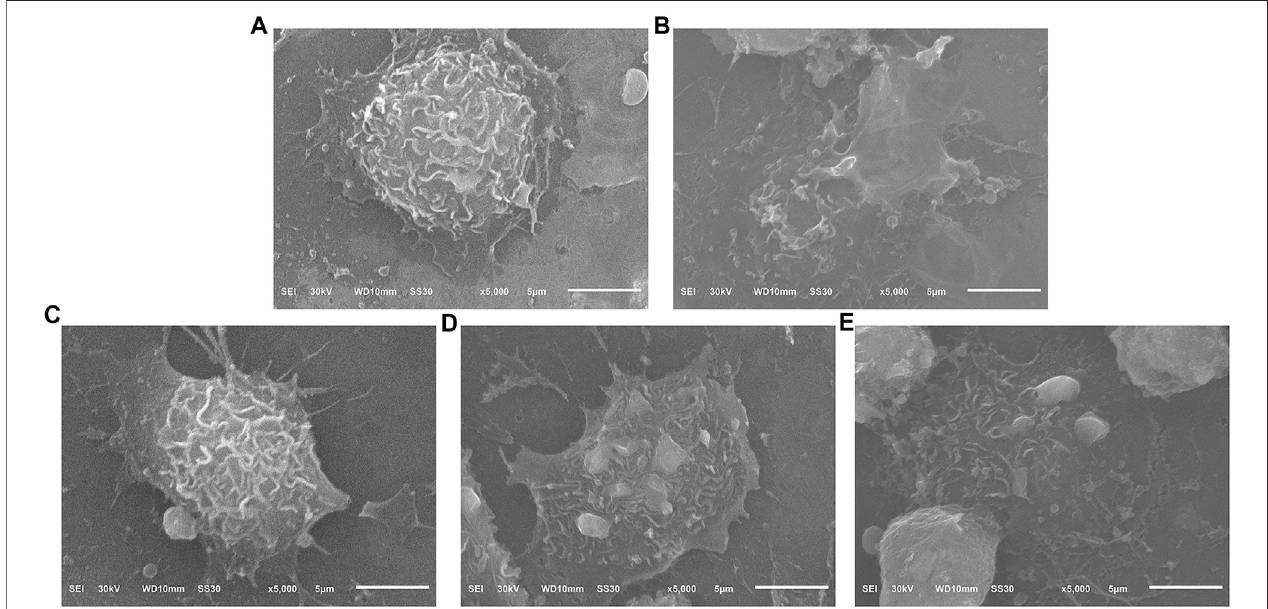
FIGURE 6 | Effects of TF on surface morphology in LPS/MSU-induced THP-1 macrophages ( × 5000). (A) Control group; (B) LPS/MSU group; (C) TF-100 μ g/ml group; (D) TF-50 μ g/ml group; (E) TF-25 μ g/ml group. Scale bar, 5 µm. TF, fl avonoid extract.